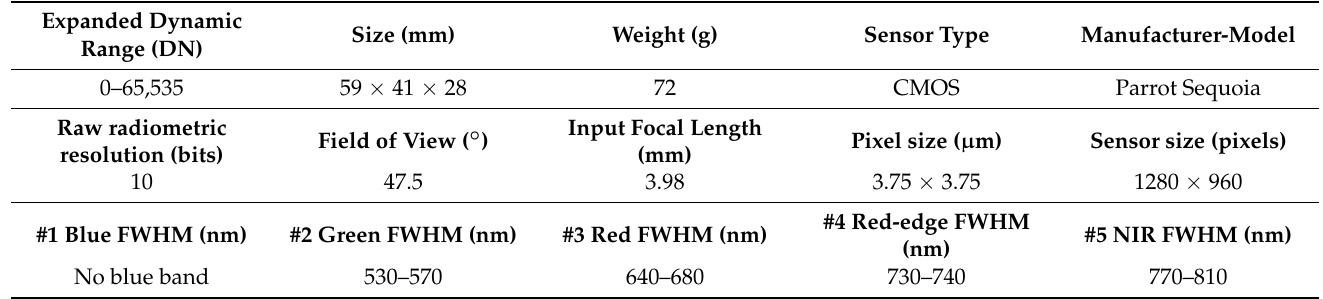
Table 3. Parrot Sequoia camera main